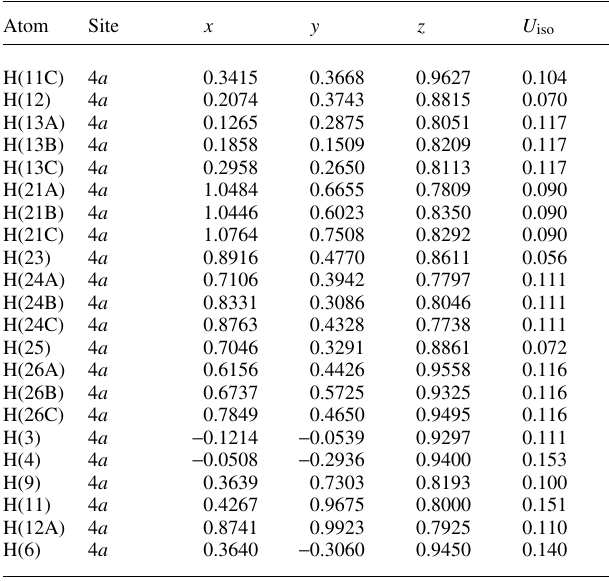
Table 1. Data collection and